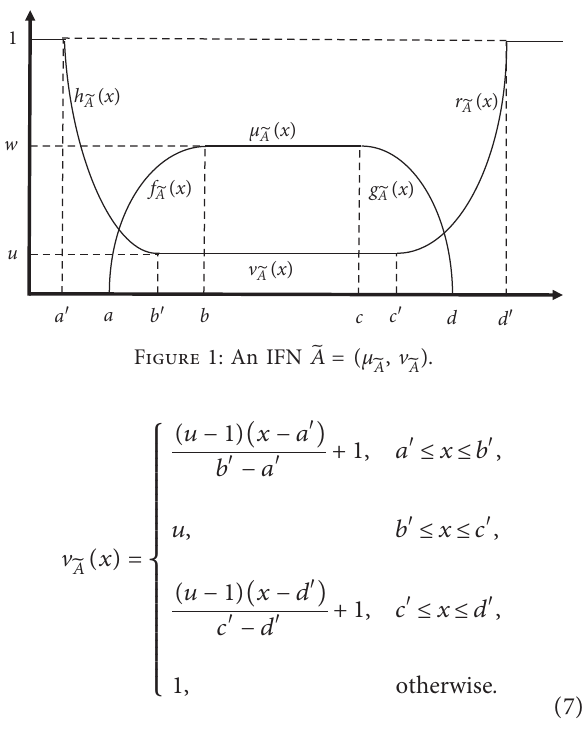
Figure 3: Hesitation degree of element x ( π ( x )) . v 􏽥 A